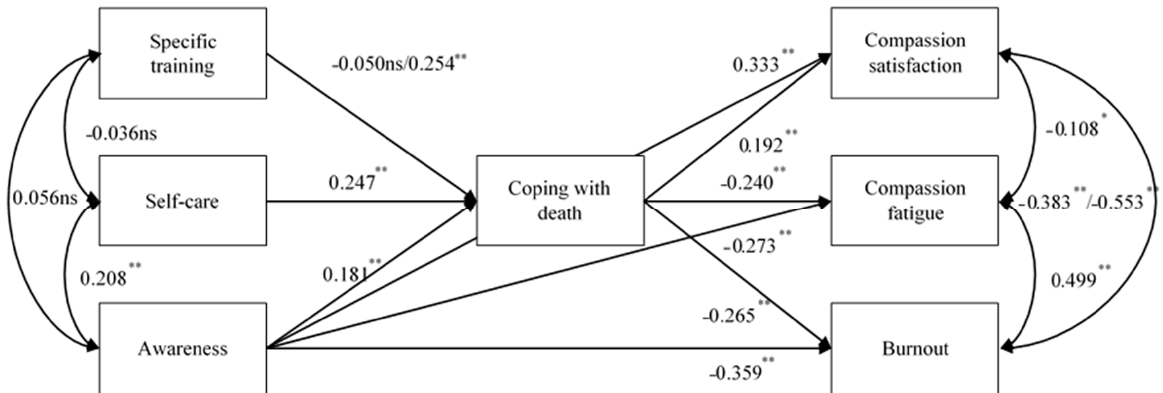
Figure 2. The most parsimonious model with the standardized parameter estimates. Notes: * p < 0.050 and ** p < 0.001. The non-invariant parameter estimates are those that are duplicated. The first value in the relationship between specific training and coping with death refers to the Spanish sample; the second is that of the Argentinian and Brazilian samples. The first value in the relationship between compassion satisfaction and burnout is for the Spanish and Argentinian samples; the second one is for the Brazilian sample. For the sake of clarity, standard errors are not shown.